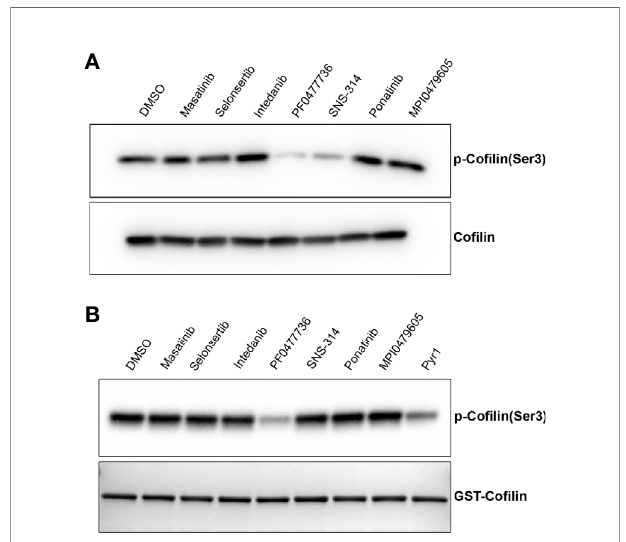
FIGURE 6 | Some kinase inhibitors target the co fi lin pathway. (A) Cellular LIMK activity is reduced when cells are treated with some kinase inhibitors. HeLa cells were treated for 2 h with 10 µM of kinase inhibitors. Cell lysates were separated by SDS-PAGE and immunoblotted using anti-phosphoco fi lin (ser3) or anti-co fi lin antibodies as indicated. (B) In vitro phosphorylation of recombinant GST-co fi lin. GST-co fi lin (2.9 µM) was incubated with LIMK (100 nM) in kinase buffer in the presence of the different kinase inhibitors as described in the Materials and Methods section. DMSO was used as negative control. Proteins were separated by SDS-PAGE and co fi lin phosphorylation was analyzed after immunoblotting using the anti-phosphoco fi lin (ser3) antibody. A coomassie-stained SDS-PAGE gel shows the corresponding content of GST-co fi lin in each sample.